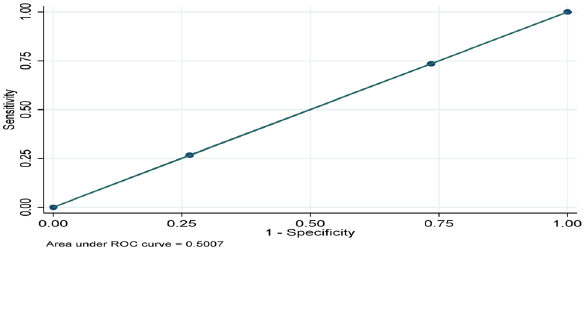
Fig. 10 ROC for RCS. Source: Researchers’ Analysis